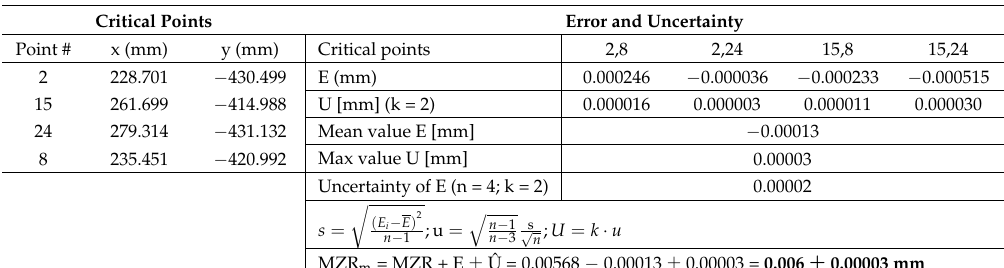
Table 7. Roundness measurement Case 6. Error and uncertainty results for minimum zone criteria. Values in (mm).